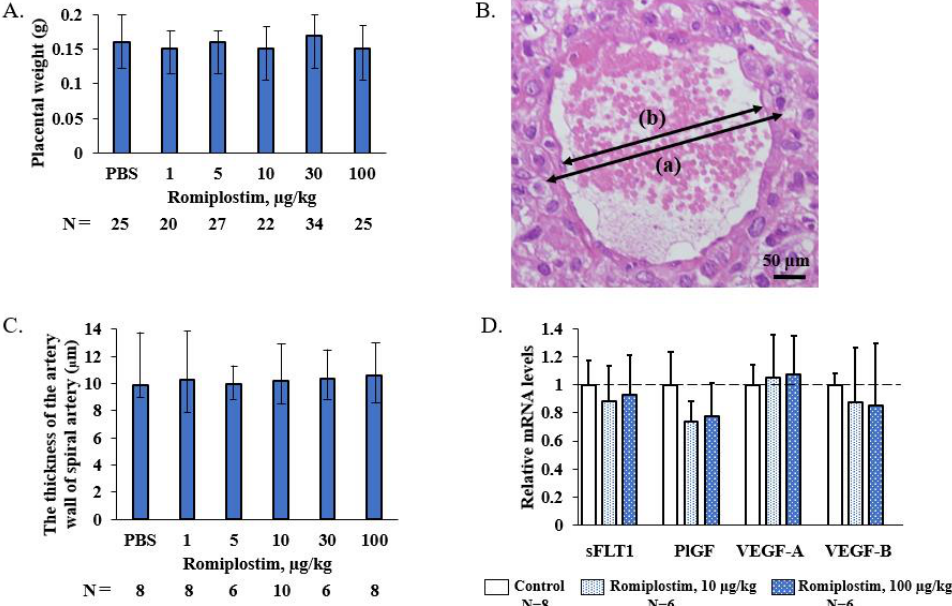
Figure 4. Fetal weight at birth of pregnant mice treated with romiplostim. The administration of 100 µg/kg of romiplostim to pregnant mice significantly reduced fetal weight at birth, compared to the control group. Bars represent the median. Error bars represent range. ** p < 0.01.